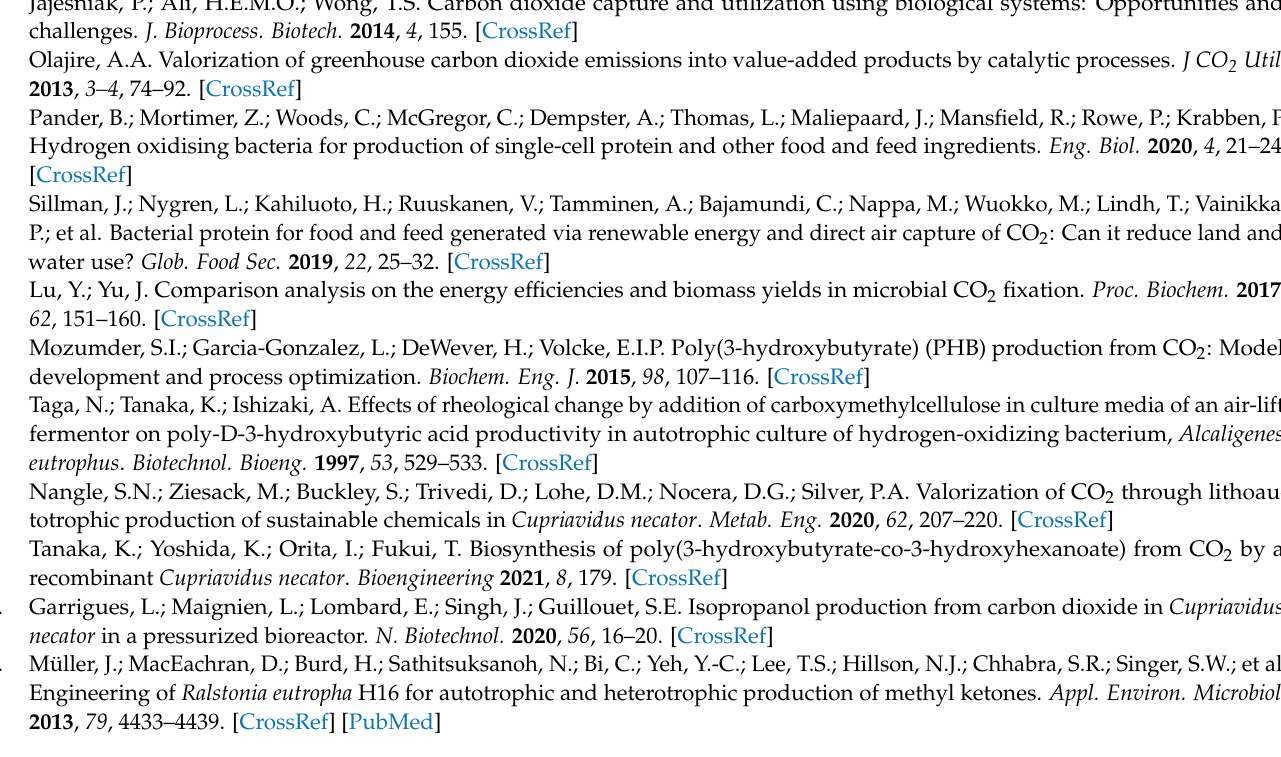
Figure S5: Heterotrophic cultivations at room temperature (22–24 ◦ C, orange dots) and at 30 ◦ C (grey dots) in 1 L baffled flasks (magnetic bar, stirring at 400 rpm); Figure S6: Determination of maximal growth rates from chemoautotrophic cultivations depicted in Figures 6 and 7 (main part); Figure S7: Time curve of a gas fermentation with constant high O 2 supply. OD 600 values (black circles) and p O2 (blue line); Figure S8: Time curves of gas cultivations 1 (panel A) and 2 (panel B) with manual DO control using a dipping probe (supplementing Figure 7A main part); Table S1: Maximal growth rates ( µ max h − 1 ) obtained at room temperature or 30 ◦